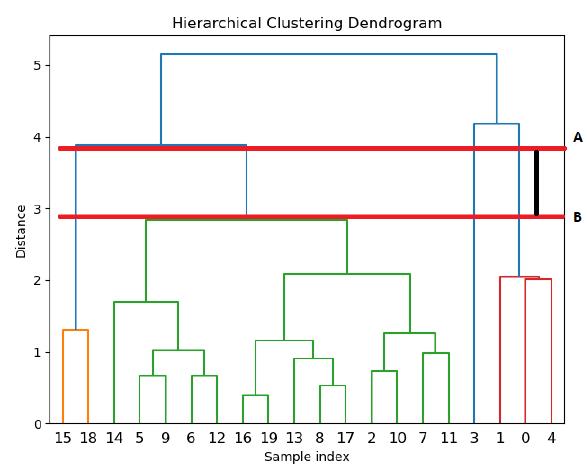
Figure 1. Dendrogram example